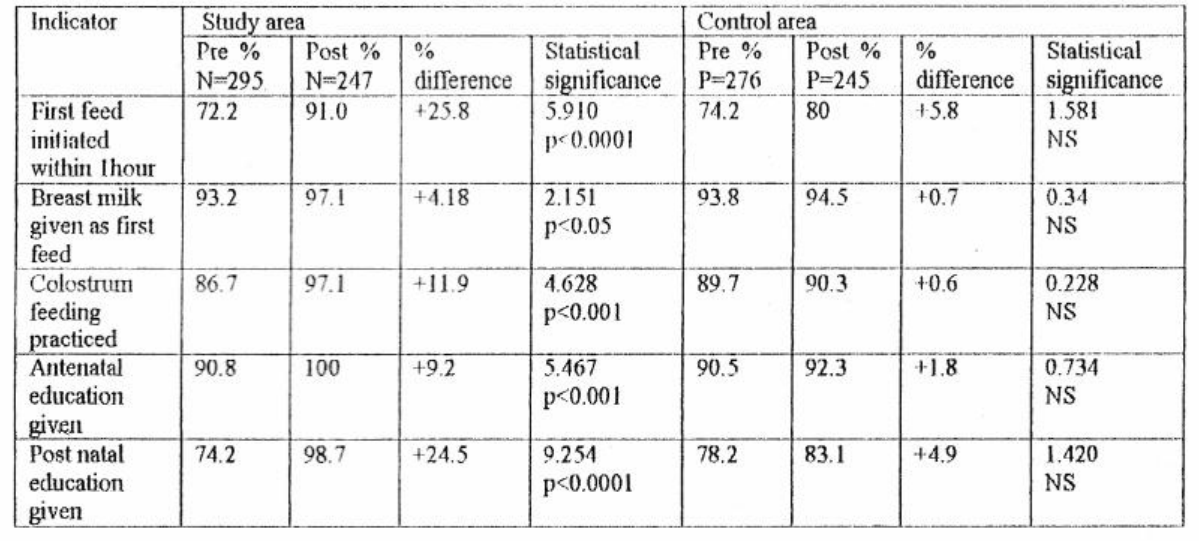
‘Table 2 Percentage changein practices promoting breast feeding practices in study and control ateas ~ pre and post